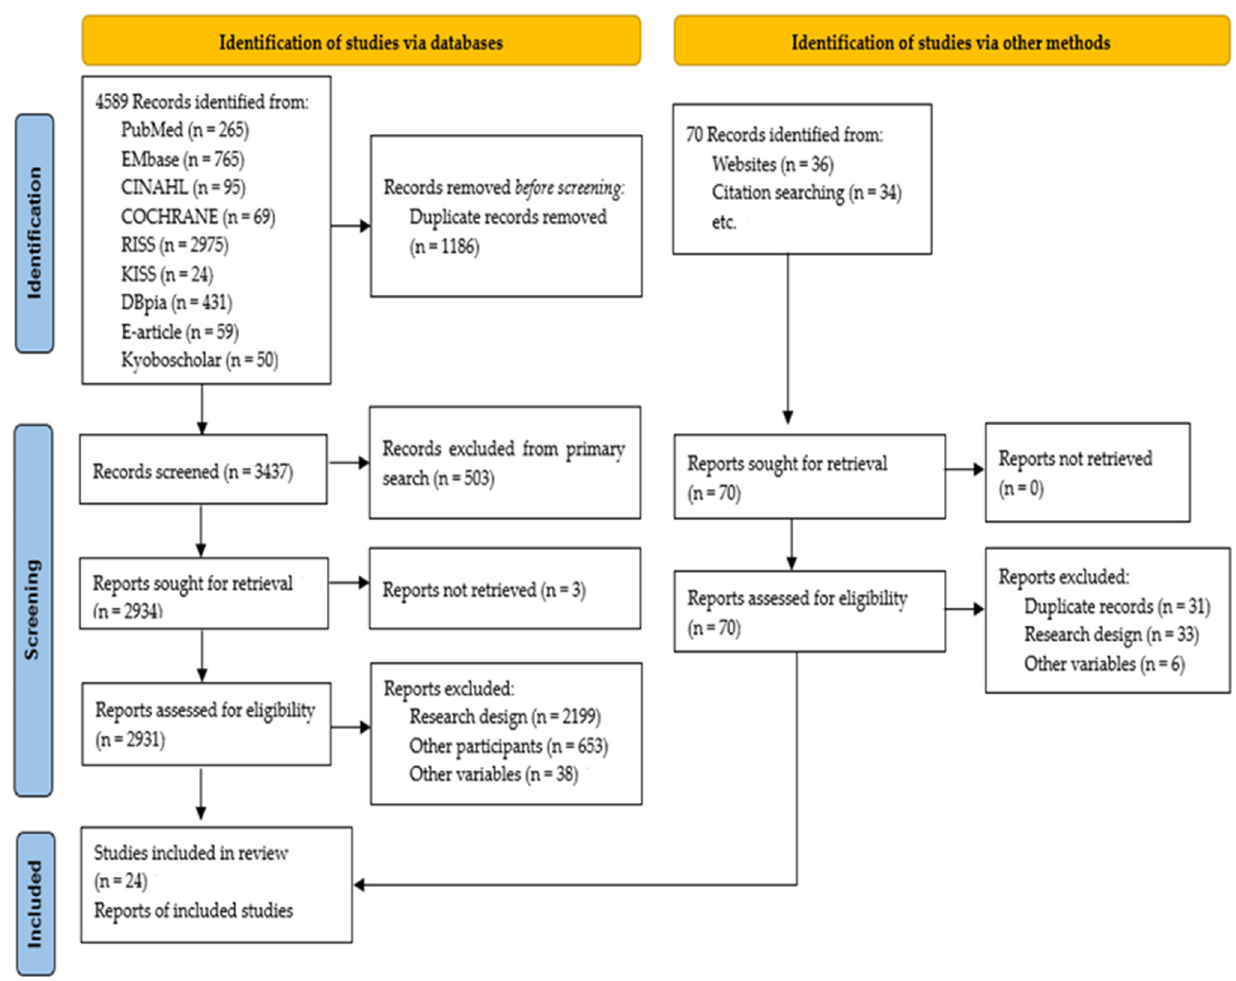
Figure 1. PRISMA flow diagram.